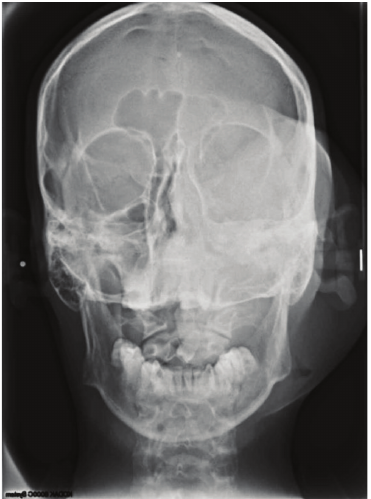
Figure 5: PA view showed erosion of the left maxilla and downward displacement of